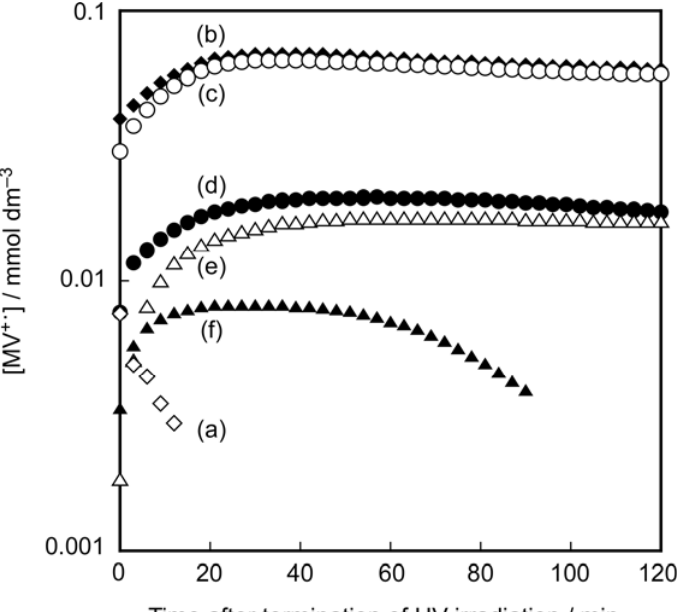
Figure 11. Time courses of the concentration of MV +• species observed after termination of UV-irradiation in the clay–niobate colloids added by MV 2+ with composition of [clay] = 1 (a, open diamonds), 5 (b, filled diamonds), 10 (c, open circles), 20 (d, filled circles), 25 (e, open triangles), and 30 (f, filled triangles ) g L –1 , [niobate] = 1 g L –1 and [MV 2+ ] = 0.1 mmol L –1 [186]. Reprinted with permission from Ref. [186]. Copyright 2009 American Chemical